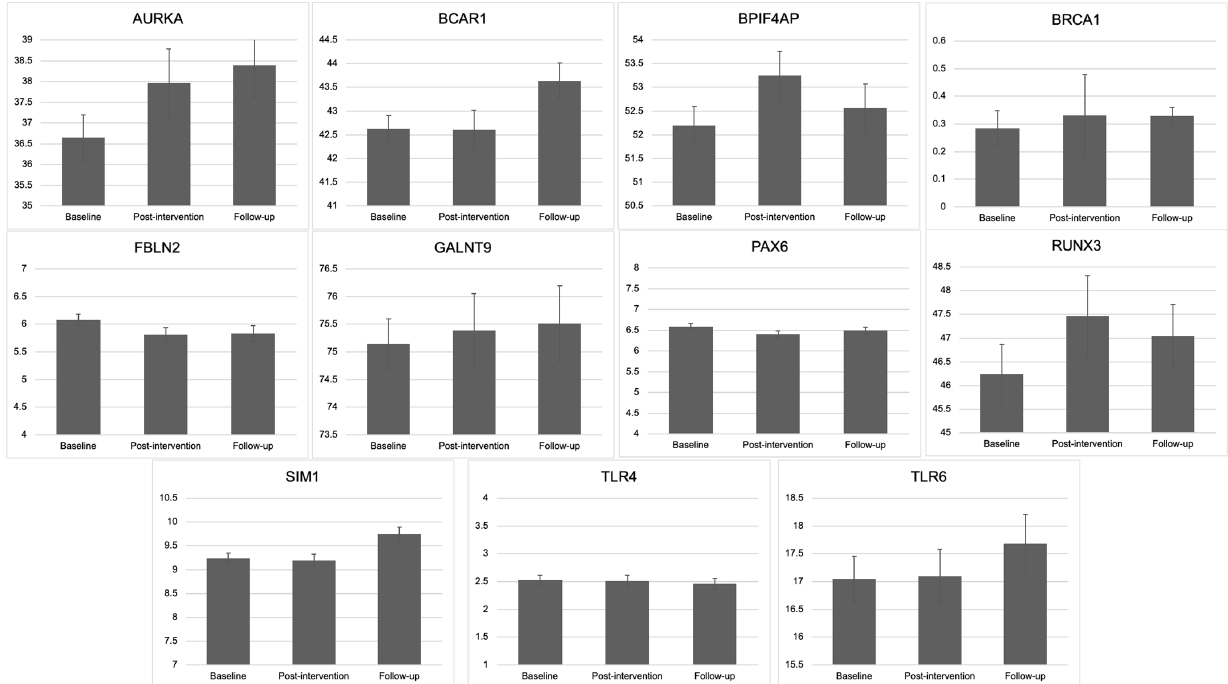
Figure 2. Average percent methylation for each gene at each time point, on average across condition. Y -axis for each panel represents % methylation. Bars are standard error bars.